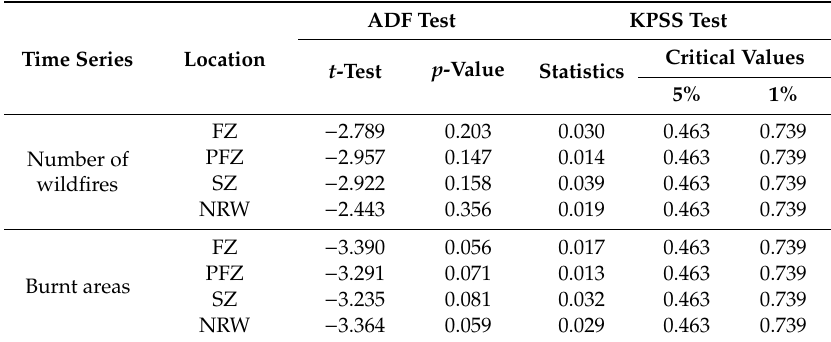
Table 1. Summary of Augmented Dickey–Fuller (ADF) and Kwiatkowski–Phillips–Schmidt–Shin (KPSS) tests of pyrological time